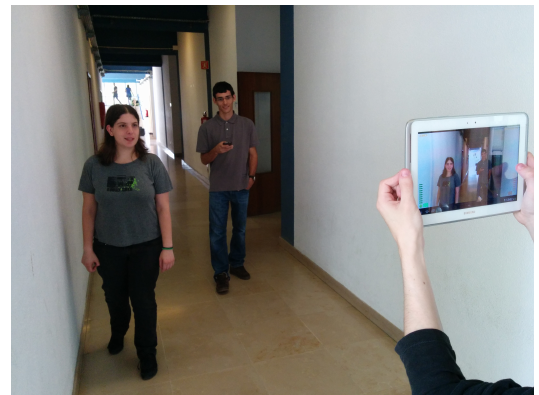
Figure 5: ARZombie game being played indoor.